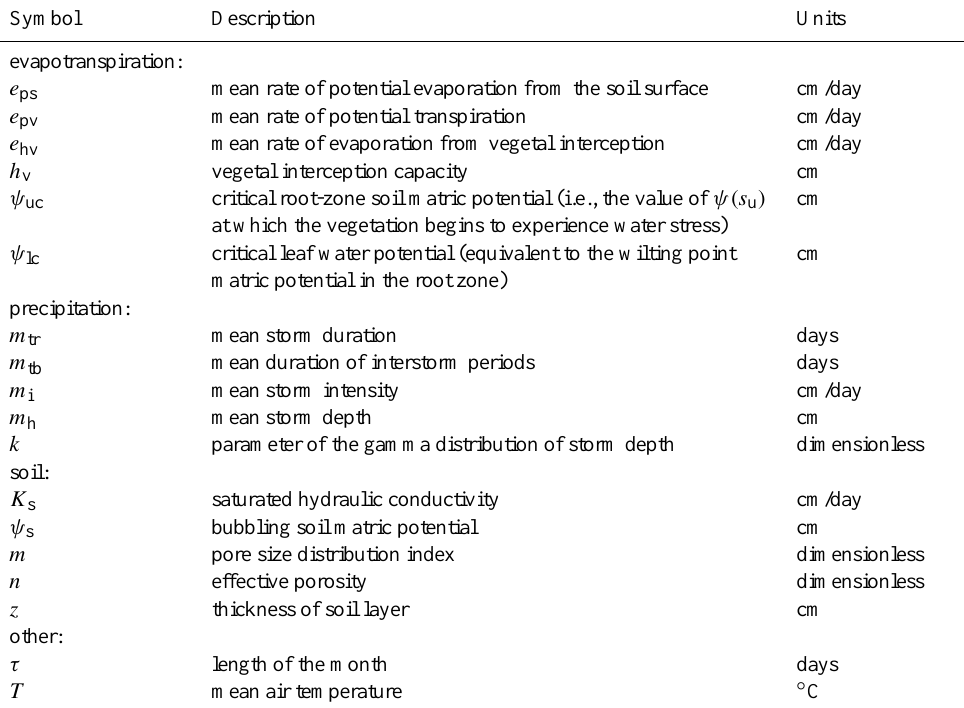
Table 1. Main parameters of the statistical-dynamical ecohydrology